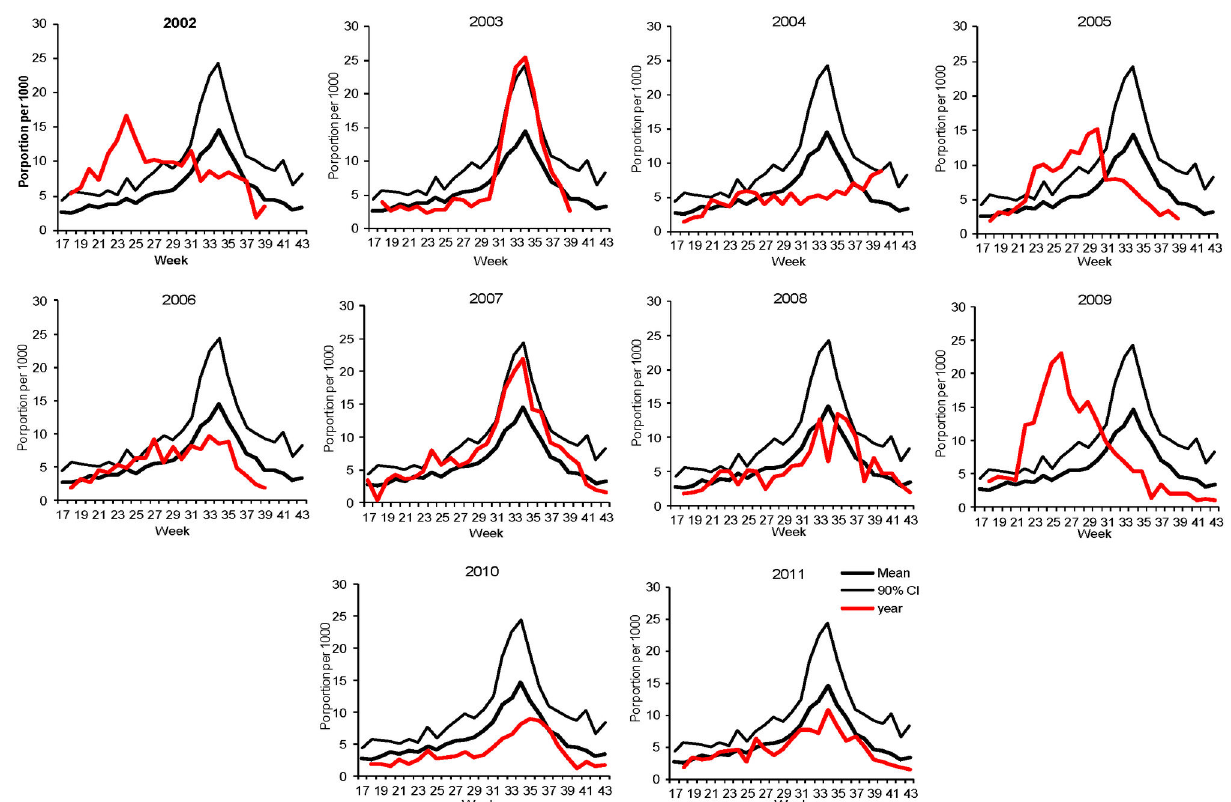
Figure 3. Annual data (red) plotted against the ten year average season (black) for the GPSS, 2002-2011.